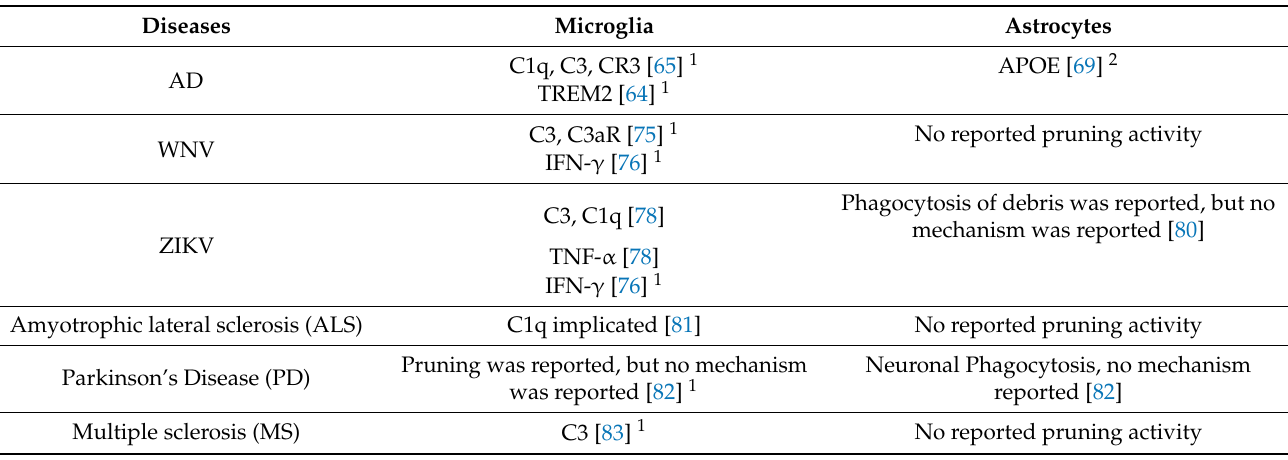
Table 1. Glia-mediated synaptic pruning mechanisms in disease